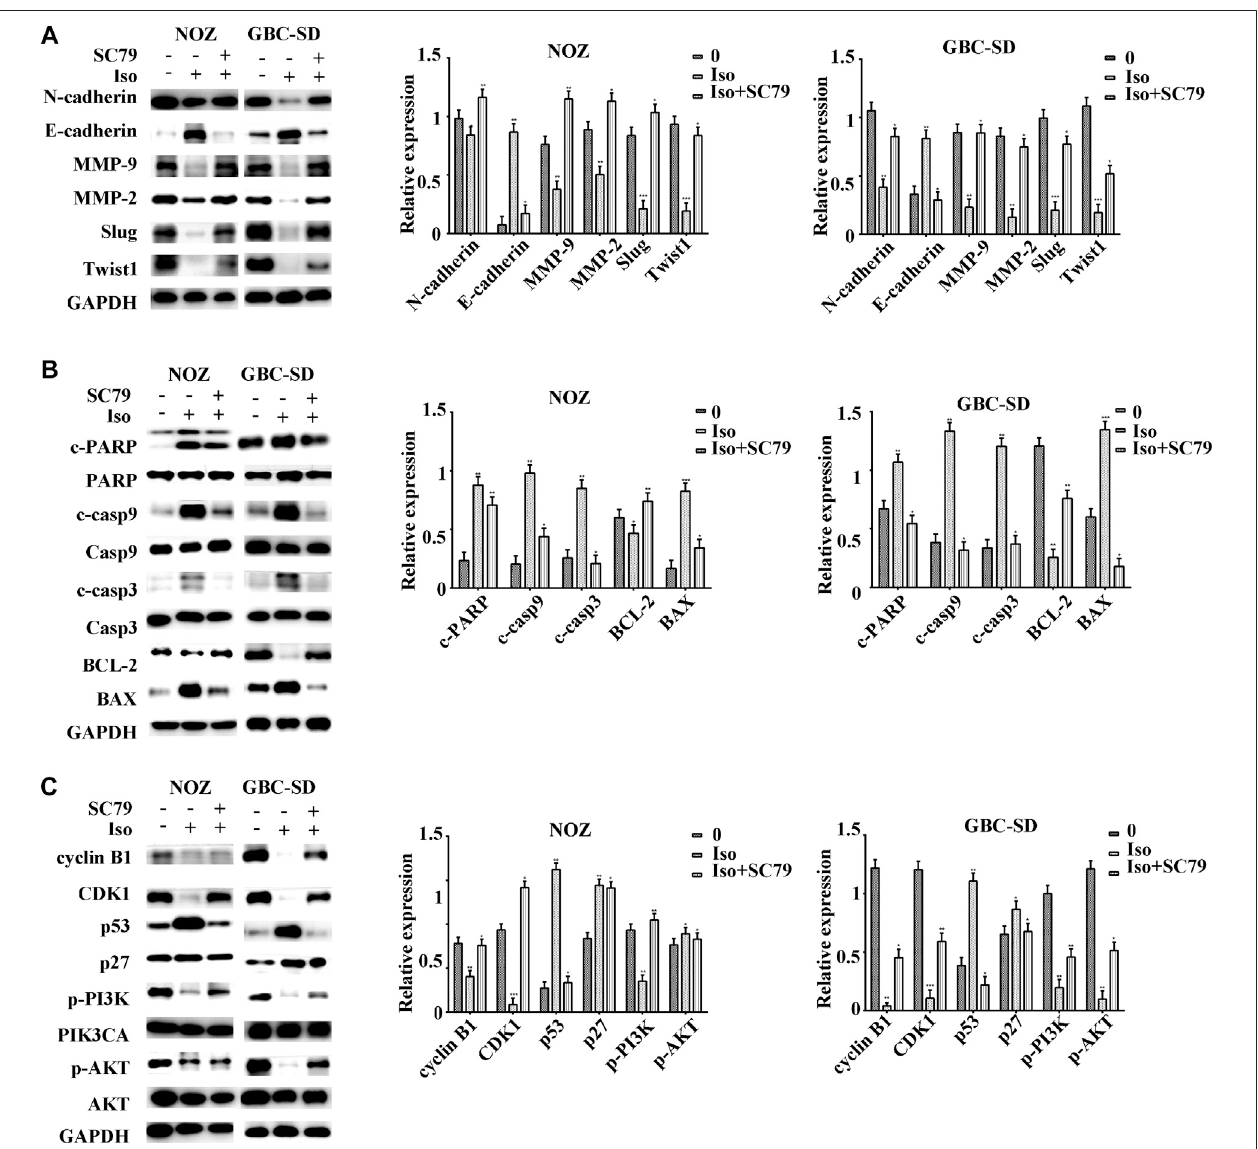
FIGURE6| IsorhamnetininhibitsGBCcellproliferationandmetastasisviathePI3K/AKTpathway.AfterpretreatmentwithSC79for1h,theexpressionlevelsof (A) MMP-2, Slug,MMP-9,E-cadherin,N-cadherin,TWIST1, (B) cleavedPARP,PARP,BAX,cleavedcaspases9,caspases9,BCL-2,cleavedcaspases3,caspases3, (C) cyclinB1,CDK1, p27, p53, p-PI3K, p-AKT1, PIK3CA, and AKT were detected and shown with statistic results. * p < 0.05, ** p < 0.01, *** p < 0.001 relative to the control group.